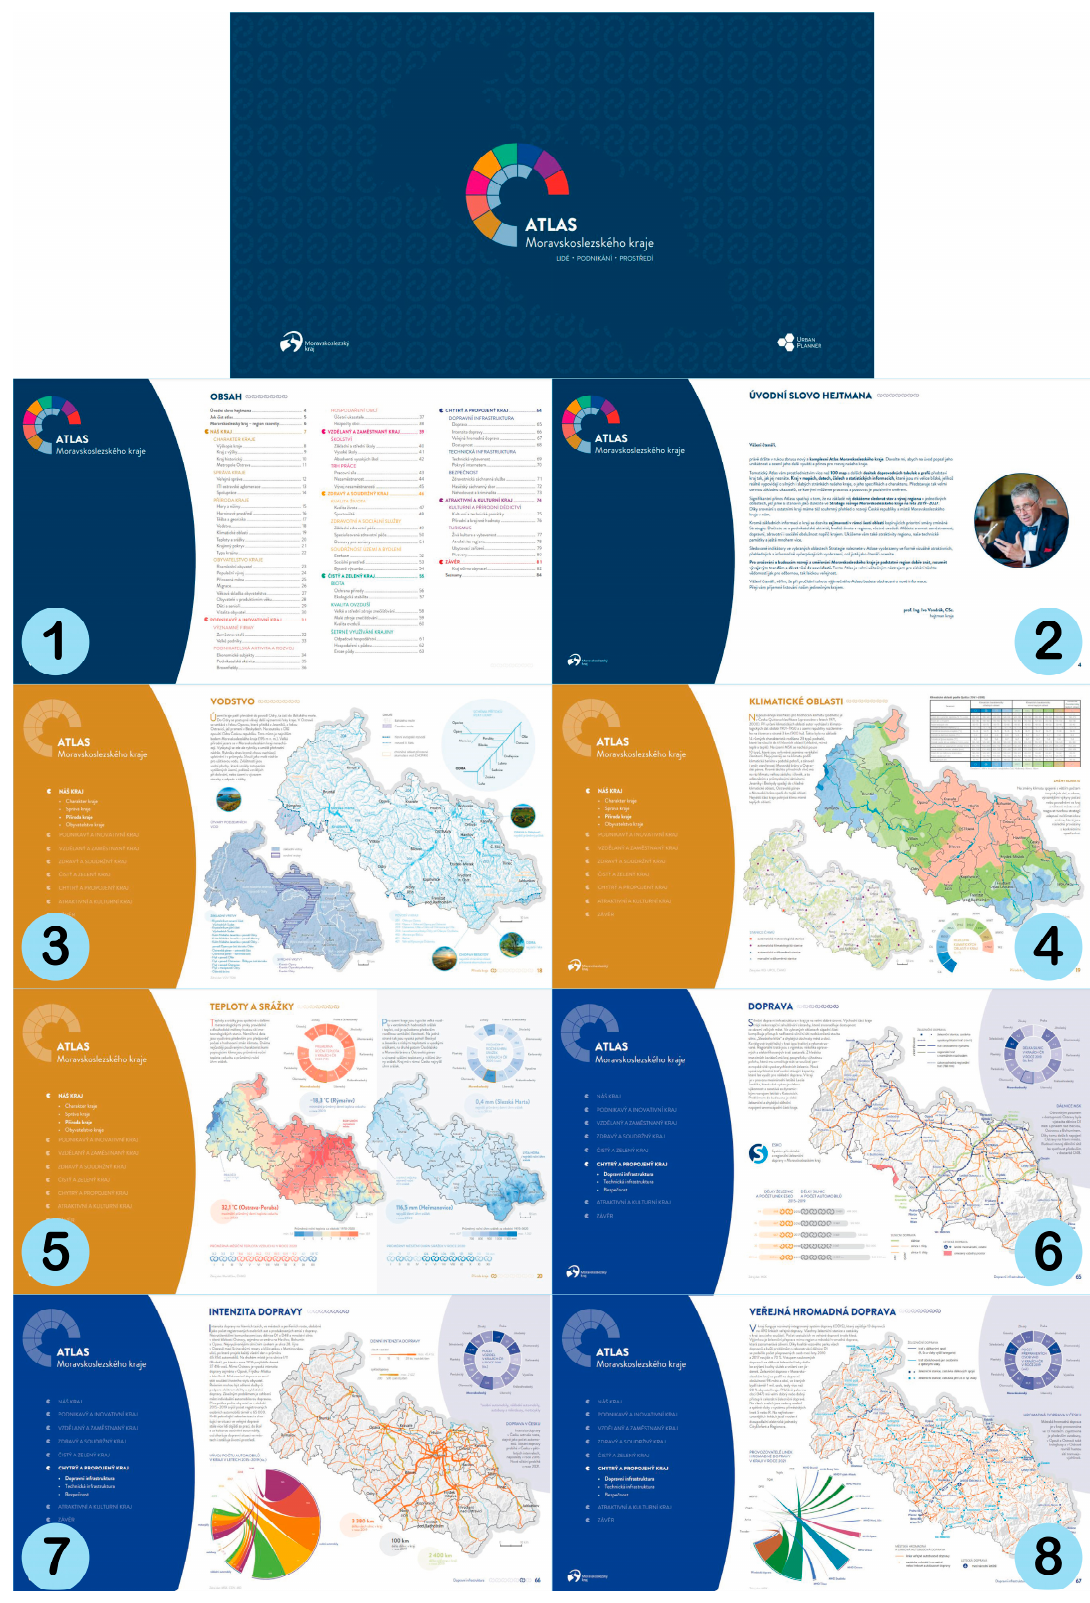
Figure 3. Examples of the content in the Atlas of the Moravian-Silesian Region .